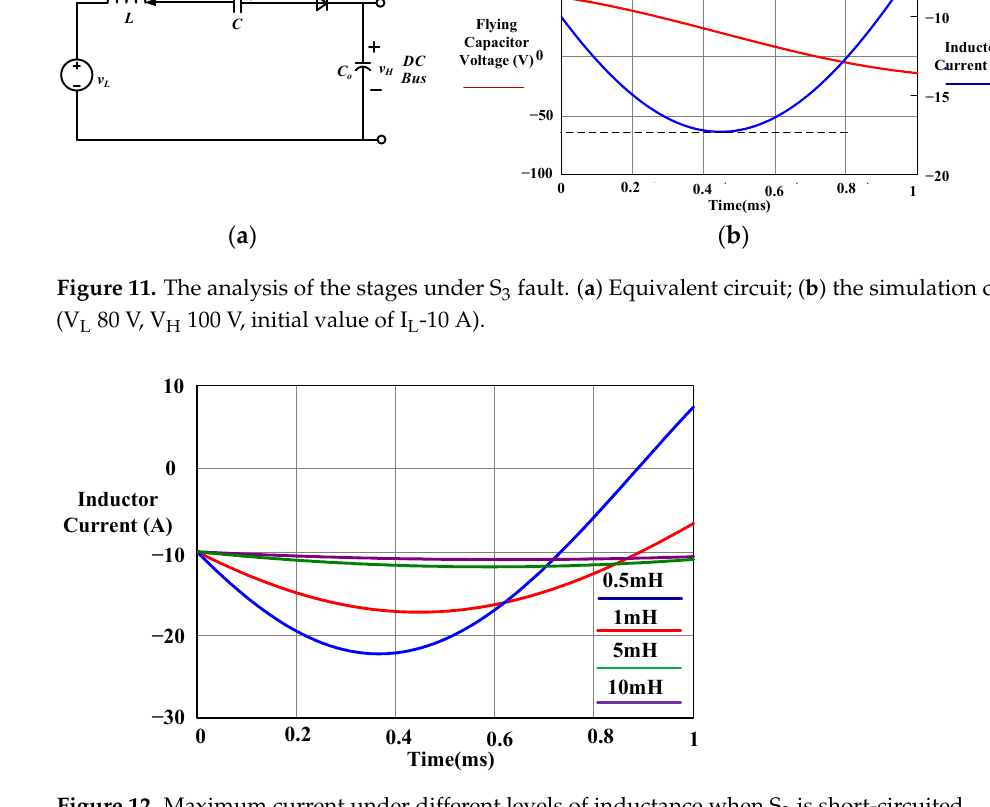
The current spike analysis when S 4 is short-circuited is shown in Figure 13. When the